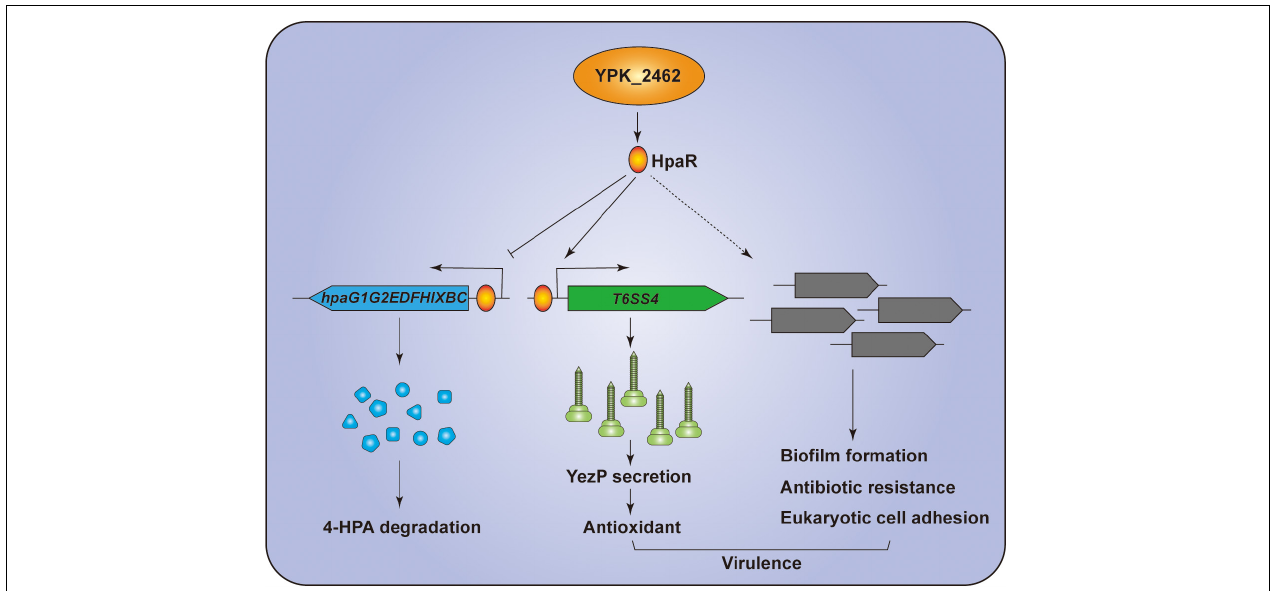
FIGURE 7 | Hypothetical model for the function of HpaR in Y. pseudotuberculosis . HpaR represses the 4-HPA catabolic pathway but activates the transcription of T6SS4 to maintain ROS levels in response to oxidative stress. HpaR also affects the biofilm formation, eukaryotic cell adhension, antibiotic resistance, and virulence of Y. pseudotuberculosis